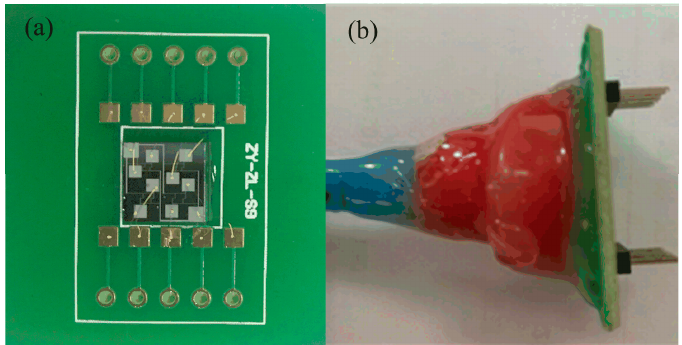
Figure 10. ( a ) Photograph of the pressure-welded array-type piezoresistive pressure sensor on the printed circuit board (PCB); ( b ) photograph of the packaged array-type piezoresistive pressure sensor.